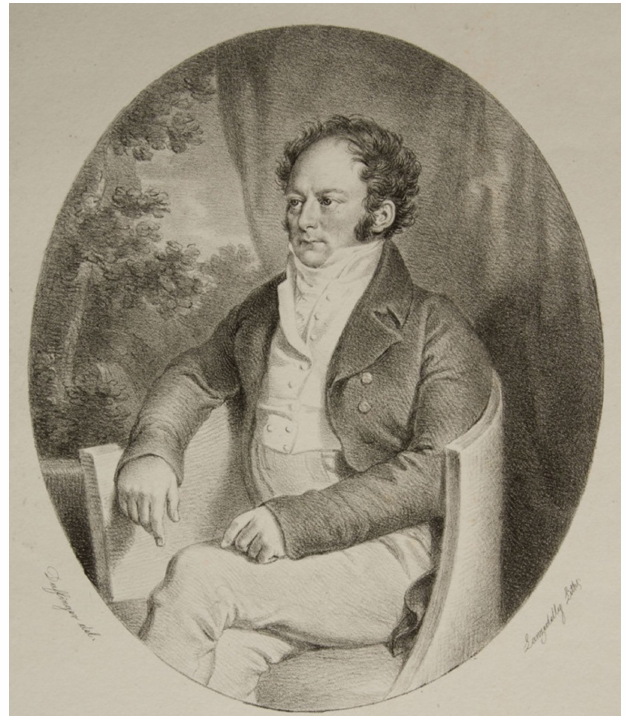
Figure 2. Portrait of the philanthropic count Hugo Salm leading figure of the agricultural and industrial revolution in Brno. Courtesy of the National Heritage Institute, Czech Republic catalogue number: